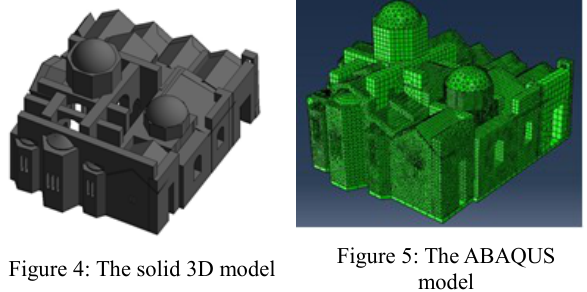
Figure 4: The solid 3D model